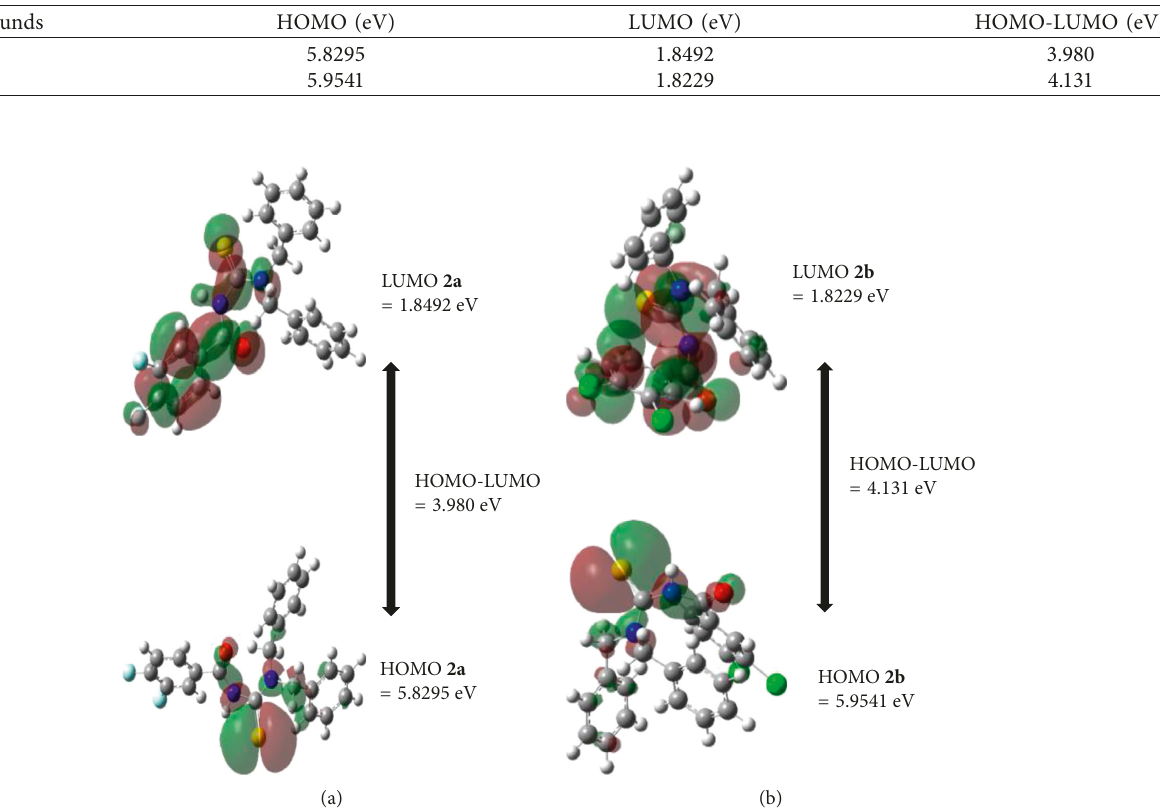
Figure 2: Frontier molecular orbitals (HOMO and LUMO) of thioureas 2a and 2b